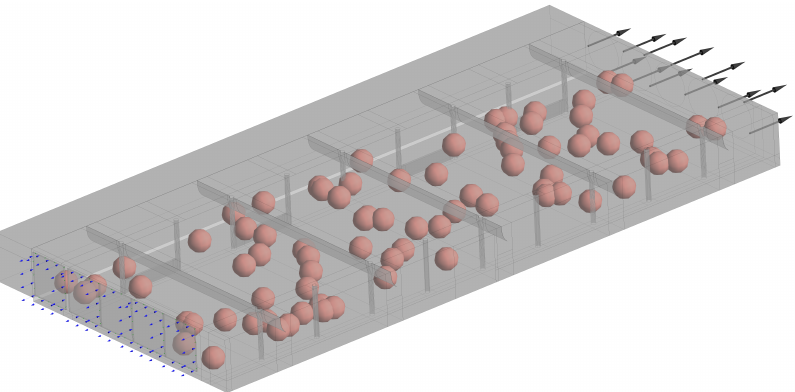
Figure 5. Setup model in the ANSYS CFX ® CFD software. The spheres represent the source points of convective heat loss from the cows, without mass, without presenting any resistance in the air flow and spatially random distributed (Appendix C). The red arrows represent the interface between the blocks meshed. The blue arrows are the opening boundary at the pad inlet and the black arrows represent the boundary condition of the exhaust fans.